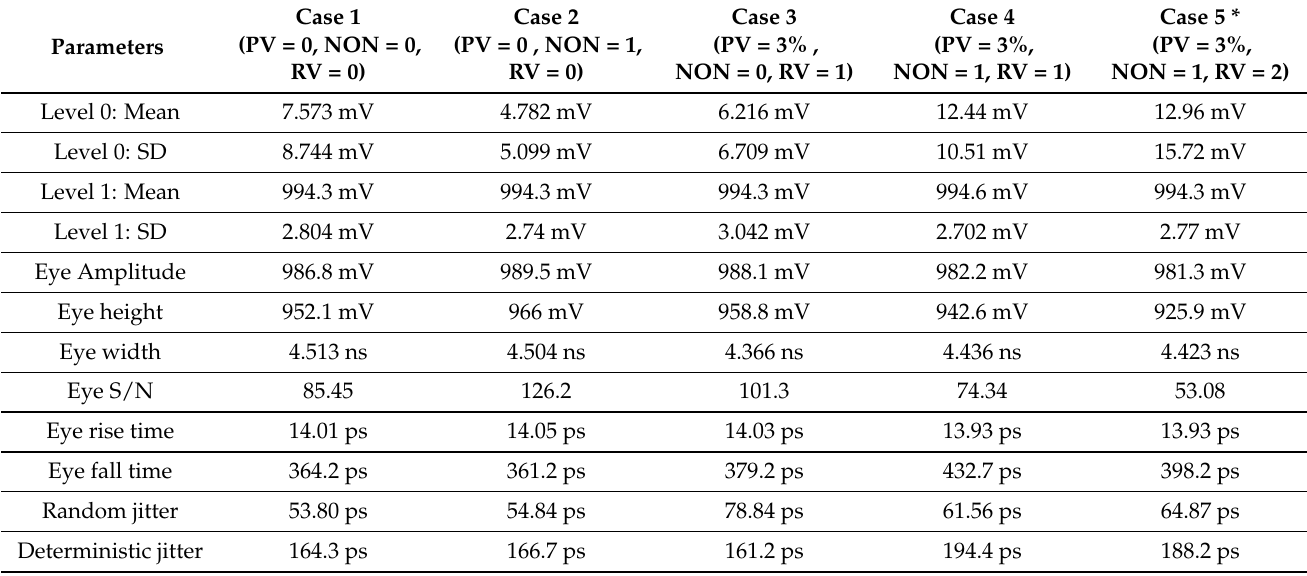
Table 4. Eye diagram performance results for NRZ